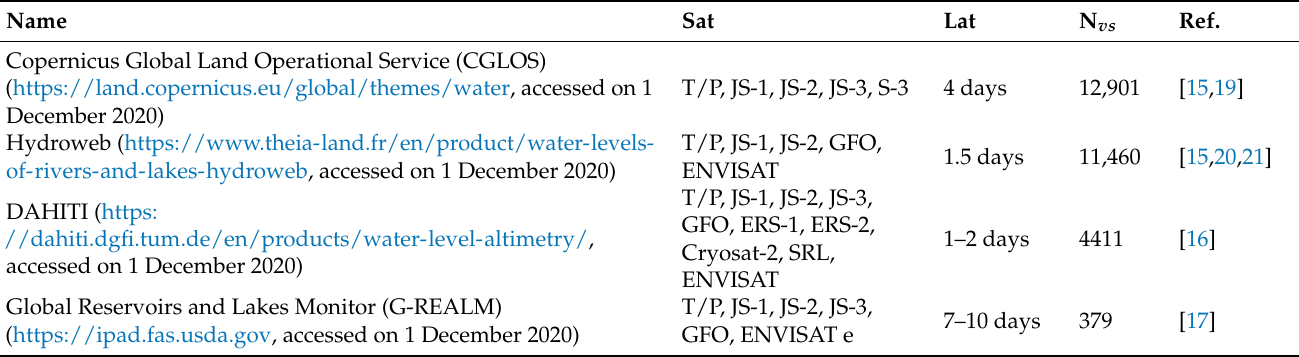
Table 1. Open access water dynamics maintained datasets at predefined locations. Includes name of the dataset (Name), satellite missions used (Sat), latency (Lat), number of virtual stations (N vs ), method references (Ref). Satellite missions’ acronyms are referred as TOPEX/Poseidon (T/P),